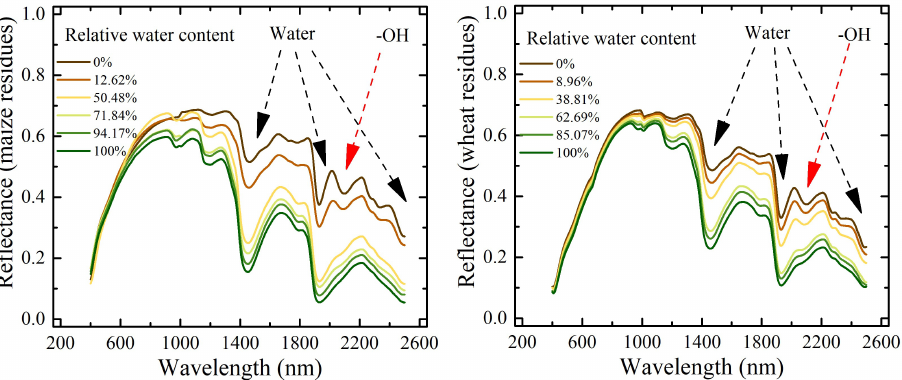
Figure 2. Reflectance spectra (400–2500 nm) of two crop residues with different relative water contents.